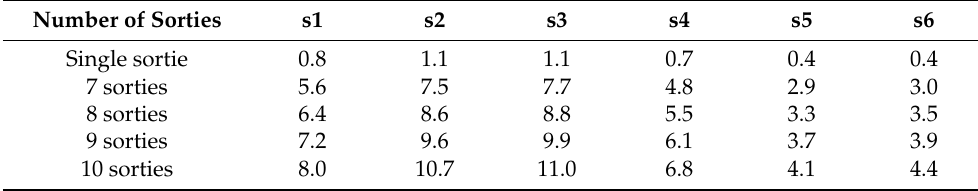
Table 7. Time gain per EA for each sortie